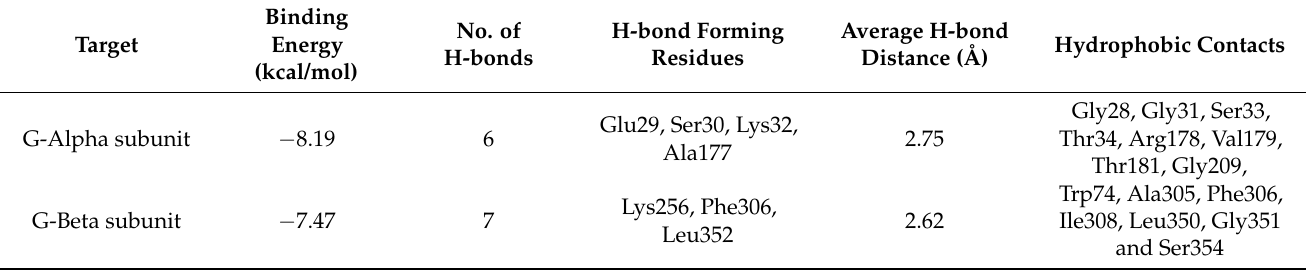
Figure 4. Docked conformational states and electrostatic surface representation of Bipolaroxin with G-protein alpha and G beta subunit. ( A ) Solid ribbon representation of the G-protein alpha subunit with Bipolaroxin (stick format) with the binding pocket residues. ( B ) Electrostatic surface potential map of G-protein alpha subunit with Bipolaroxin (ligand binding pocket has been marked in cir- cle). ( C ) Solid ribbon representation of the G protein beta subunit with Bipolaroxin (stick format). ( D ) Electrostatic surface potential map of G protein beta subunit with Bipolaroxin (ligand binding pocket has been marked in circle). The electrostatic surface potential maps were generated using APBS and rendered using Chimera.